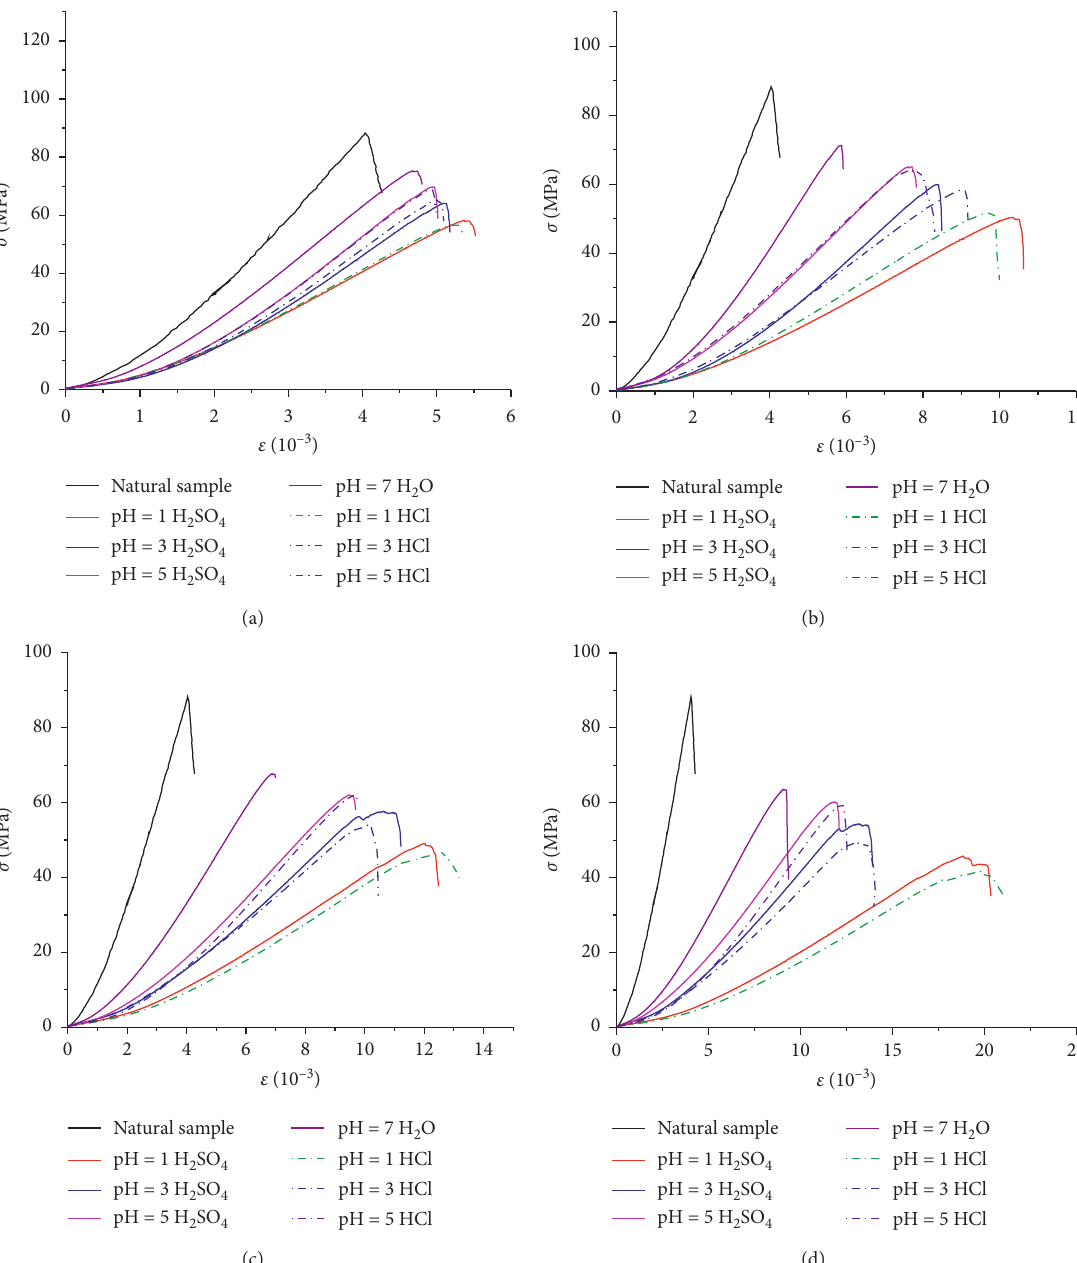
Figure 8: Uniaxial compressive stress-strain curves for sandstone samples attacked by acid solutions for different days: (a) soaking for 30 days, (b) soaking for 60 days, (c) soaking for 90 days, and (d) soaking for 180 days. Table 4: Fitting parameters of relationship between the peak stress and the elastic modulus and soaking time. Mechanical parameters